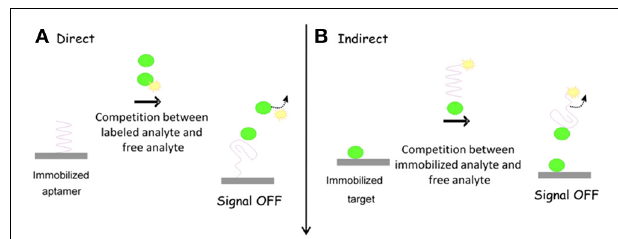
FIGURE 3 | Signal OFF formats for